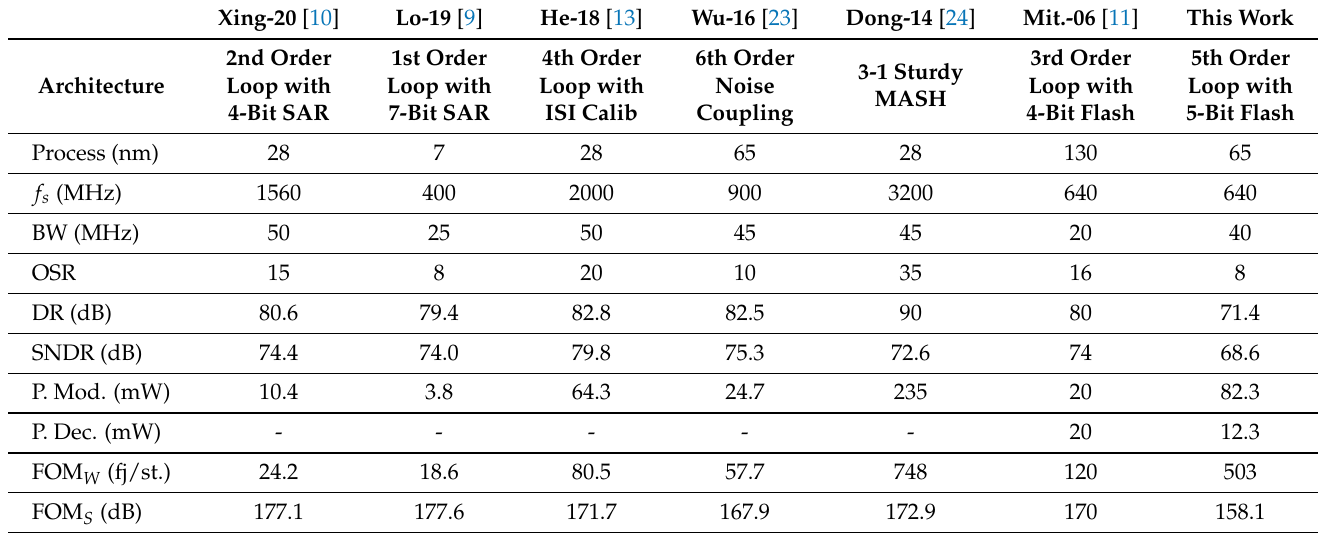
Table 6. Performance table and comparison to the state of the art. FOM W =